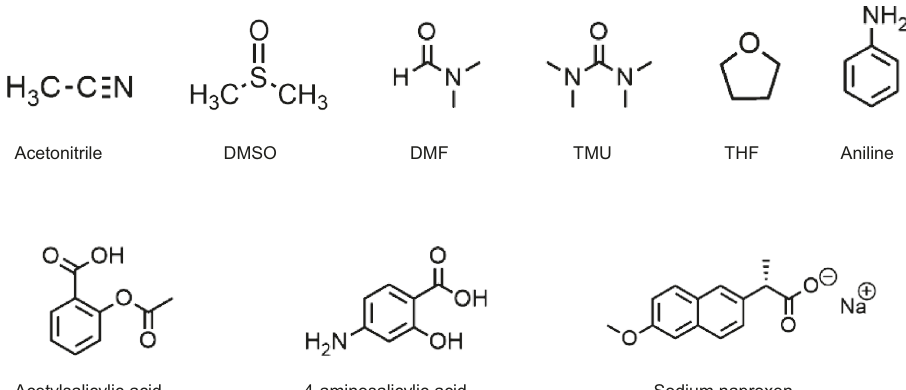
Fig. 5 Organic compounds. Selected organic compounds for the adsorption